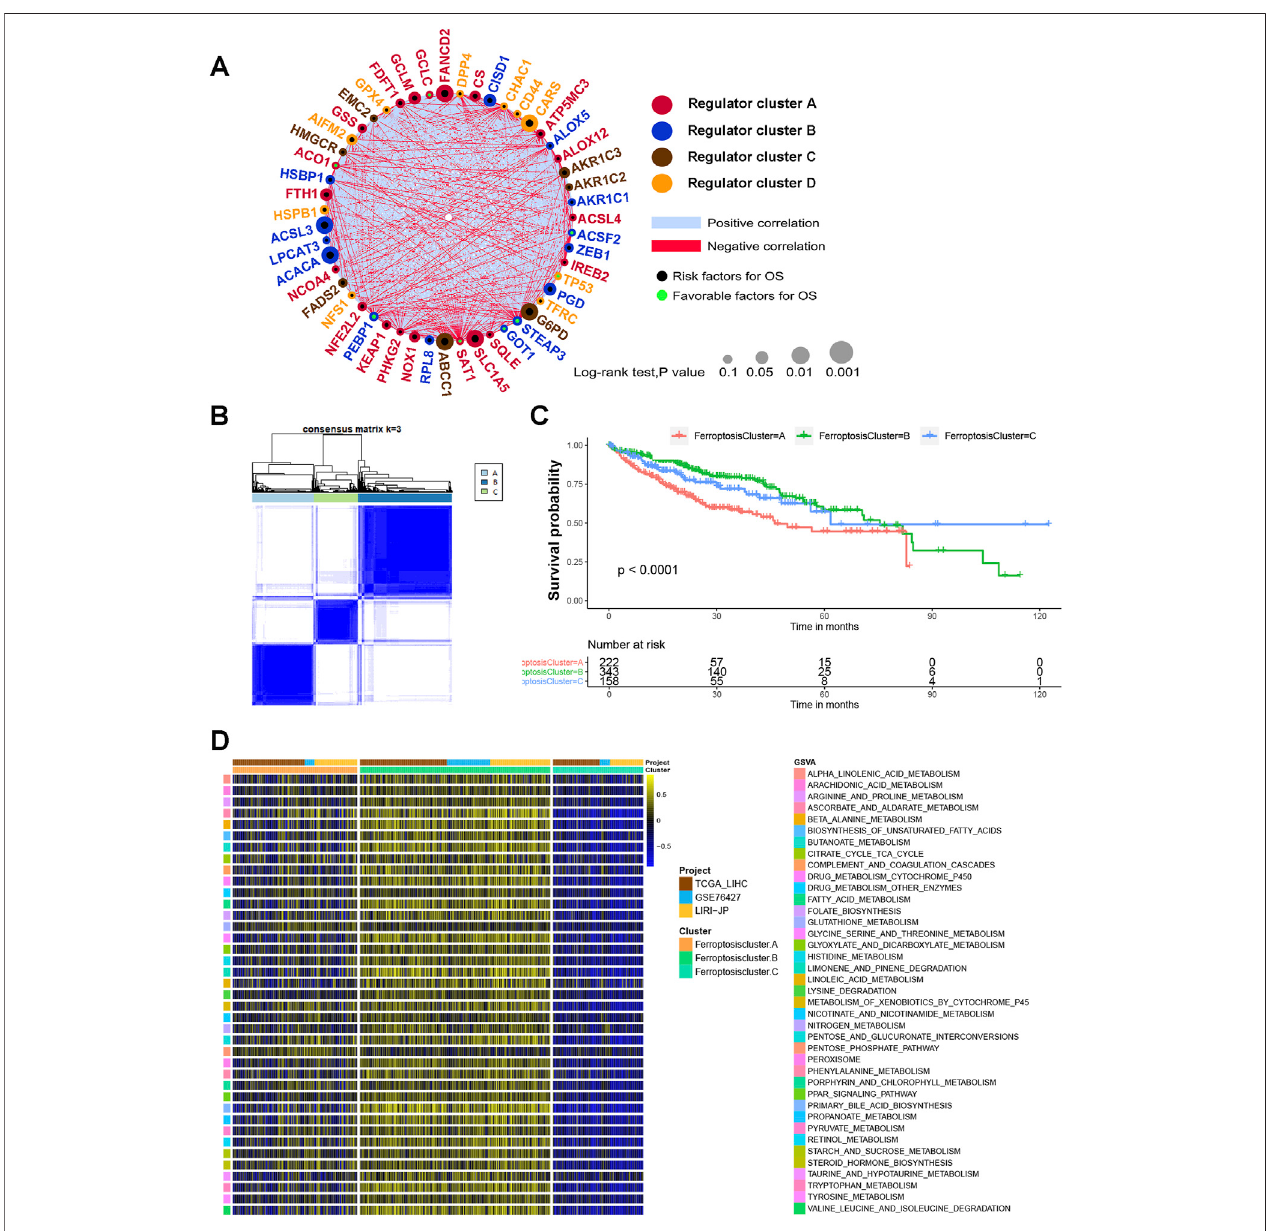
FIGURE2| Ferroptosismodi fi cationpatternsandrelevantbiologicalpathway. (A) Theinteractionofexpressionon51ferroptosisregulatorsinHCC. Thecirclesize indicated the effect of each regulator on the prognosis. Black dots, risk factors for prognosis; Green dots, favorable factors for prognosis. Negative correlation was markedwithredandpositivecorrelationwithblue.Theregulatorcellcluster (A – D) wasmarkedwithred,blue,brownandyellow,respectively. (B) Consensusmatricesof 51 ferroptosis regulators in HCC for k =3. (C) Survivalanalysisfor the three ferroptosis modi fi cation subtypes for 723HCC patients, including 222cases in pattern A, 343 cases in pattern B and 158 cases in pattern C. (D) GSVA enrichment analysis showing the activation states of biological pathways in three distinct ferroptosis modi fi cation subtypes. The cohort composition TCGA-LIHC, GSE76427, LIRI-JP were used as sample annotations.